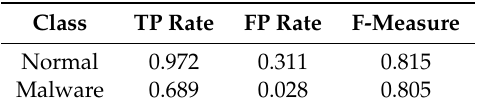
Table 9. Detailed accuracy of C5 decision tree with KDDTest + .